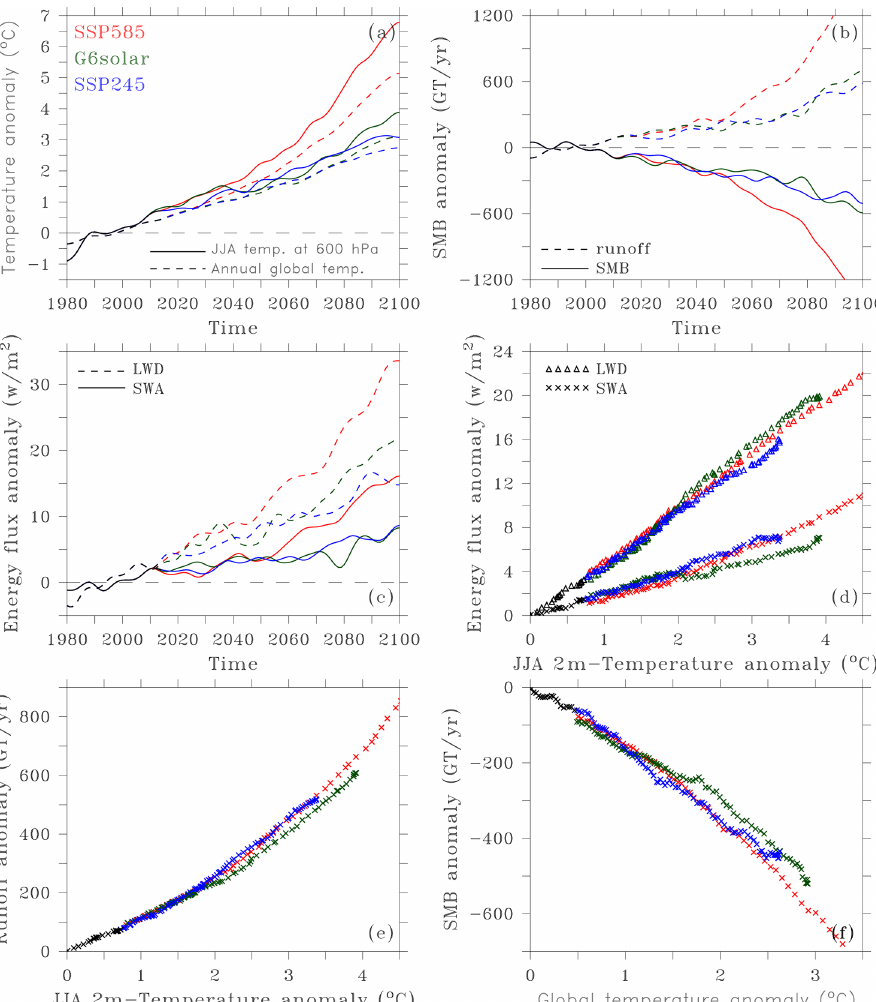
Figure 1. (a) Time series of the anomalies of the annual global near-surface temperature (dashed) and the JJA (June–July–August) tempera- ture at 600hPa over Greenland (55–85 ◦ N, 90–0 ◦ W) as simulated by CNRM-ESM2-1 using the SSP245 (blue), SSP585 (red) and G6solar (green) scenarios (the historical period is shown in black). A 30yr running mean has been applied to all the time series (values after 2086 are given by averaging the available values until 2100) and the anomalies are given with respect to the period 1981–2010. (b) Same as (a) but for the Greenland ice sheet surface mass balance (SMB in GT/yr) and meltwater runoff (dashed) as simulated by MAR using the different CNRM-ESM2-1-based scenarios. (c) Same as (b) but for the mean JJA incoming longwave radiation (LWD in W/m 2 ) and absorbed solar radiation (SWA in W/m 2 ) anomalies averaged over the Greenland ice sheet simulated by MAR. (d) Anomalies of the mean JJA incoming longwave radiation (shown by triangles, in W/m 2 ) and absorbed solar radiation (shown by crosses, in W/m 2 ) simulated by MAR compared with the MAR JJA near-surface temperature over the Greenland ice sheet. (e) Same as (d) but for the anomalies of the annual cumulated runoff over the Greenland ice sheet (in GT/yr) projected by MAR. (f) MAR anomalies of the GrIS SMB (in GT/yr) relative to annual global mean temperature anomalies from CNRM-ESM2-1 (in ◦